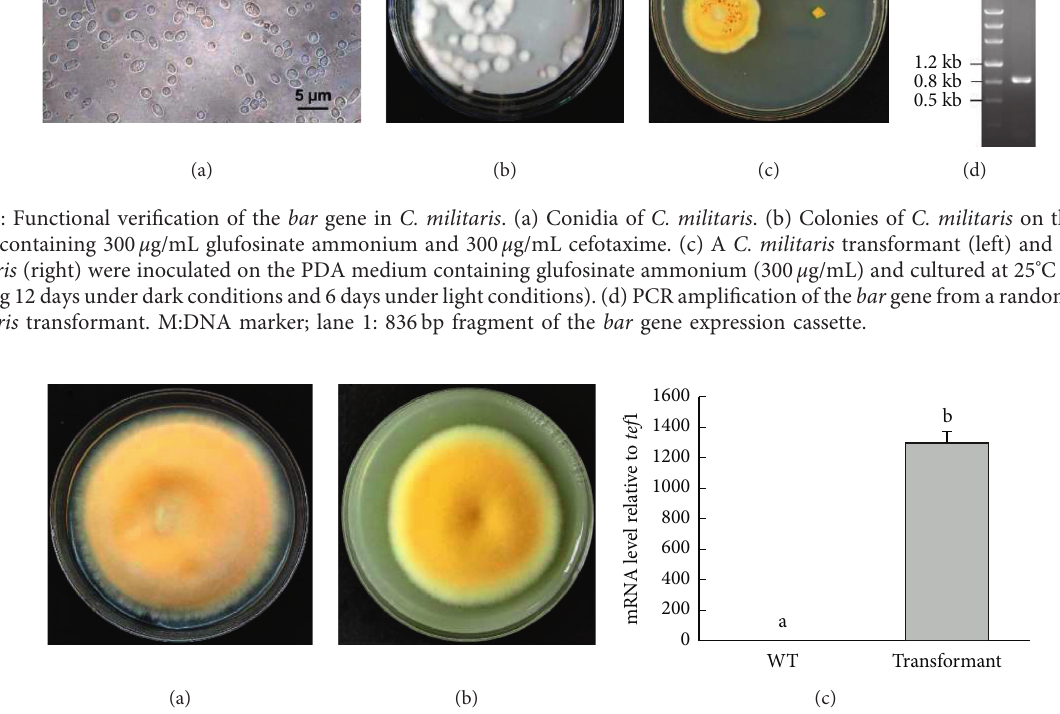
Figure 5: qRT-PCR analysis of the relative expression level of the bar gene in C. militaris transformants using the wild-type C. militaris as a control. (a) Wild-type C. militaris cultured on the PDA medium. (b) A C. militaris transformant cultured on the PDA medium. (c) Relative expression levels of the bar gene in C. militaris . Different letters (a, b) indicated that the relative expression levels of the bar gene were significantly